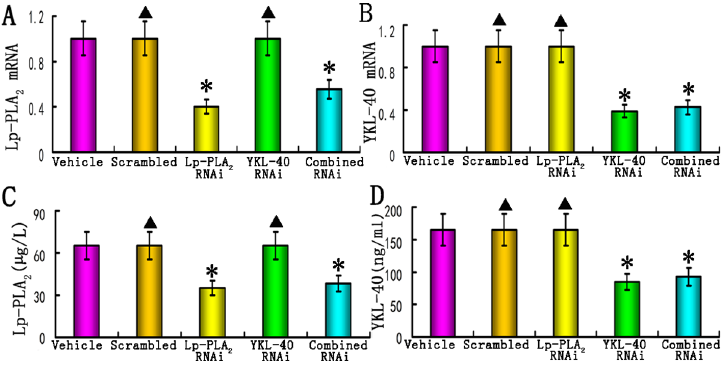
Fig 2. Knockdown of Lp-PLA 2 and YKL-40 in vivo . (A) mRNA expression of Lp-PLA 2 in the plaques of the vehicle, scrambled, Lp-PLA 2 RNAi, YKL-40 RNAi, and combined Lp-PLA 2 and YKL-40 RNAi groups (n = 12 /group); (B) mRNA expression of YKL-40 in the plaques from all groups (n = 12 /group); (C) The plasma concentrations of Lp- PLA 2 in all groups (n = 24). (D) The plasma concentrations of YKL-40 in all groups (n = 24). Vehicle = vehicle group; scrambled = scrambled group (negative control). Lp-PLA 2 RNAi = Lp-PLA 2 RNAi group, YKL-40 RNAi = YKL-40 RNAi group, combined RNAi = combined Lp-PLA 2 and YKL-40 RNAi group. Data are shown as the mean values ± S. D. (cid:3) P < 0.05 vs. vehicle groups; ▲ P > 0.05 vs. vehicle group.